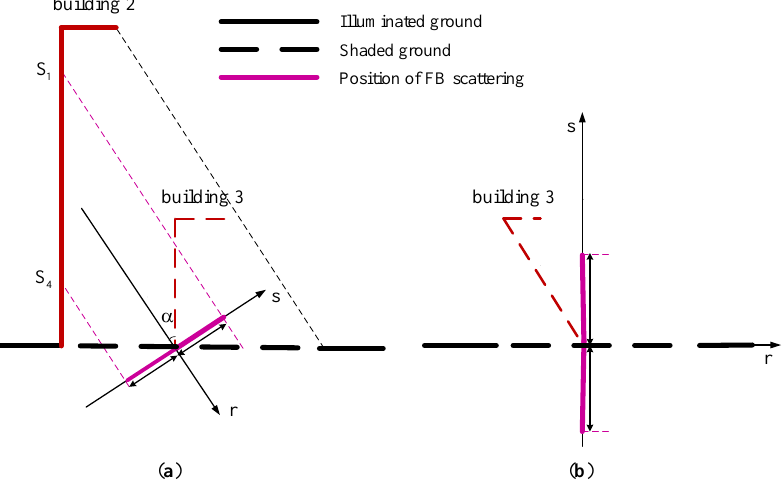
Figure 5. Schematic of the distribution of FB scattering points on ( a ) the ground–height plane, and on ( b ) the range–elevation plane. For ( b ), the flat-earth phase has been compensated.